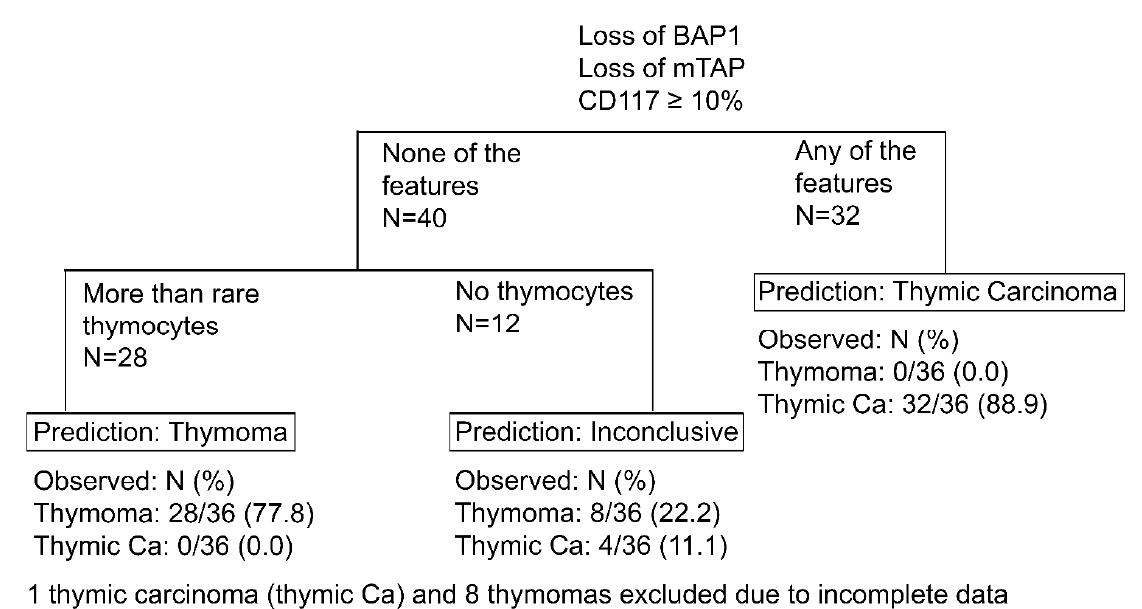
Figure 3. Proposed algorithm using BAP1, CD117, mTAP, and TdT to predict thymic carcinoma and thymomas.